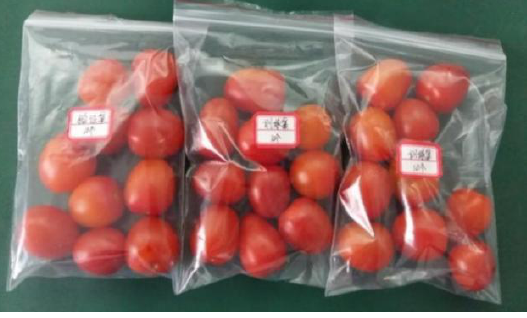
Figure 9. The cherry tomato samples.